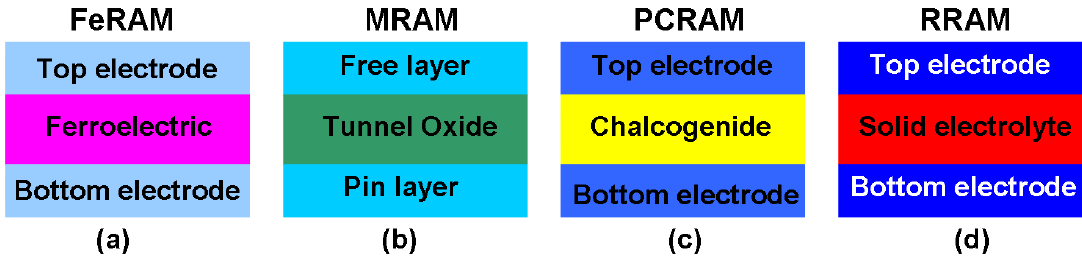
Figure 2. Layered structure of the principal non-volatile RAMs (random access memories): ( a ) FeRAM (ferroelectric RAM); ( b ) MRAM (magnetic RAM); ( c ) PCRAM (phase-change RAM) and ( d ) RRAM (resistive RAM).